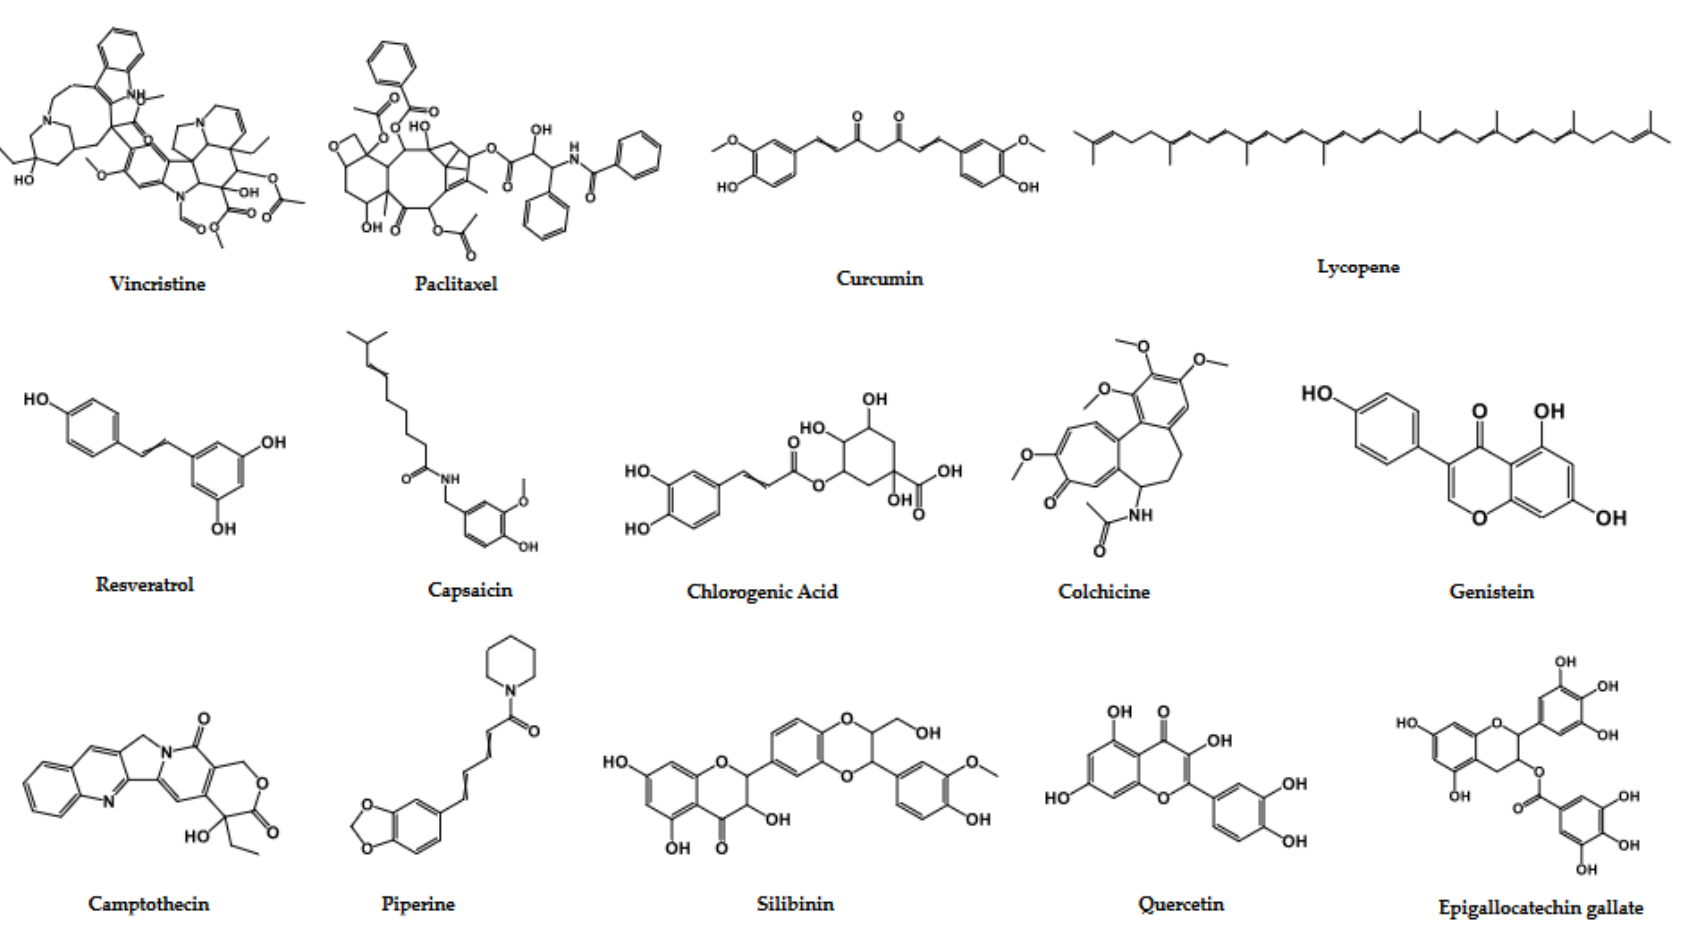
Figure 4. Structures of anticancer phytochemicals approved by FDA or in clinical trials.